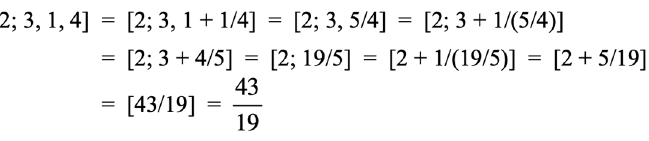
Figure 3. Computing the value of a continued fraction based on Equation (5).